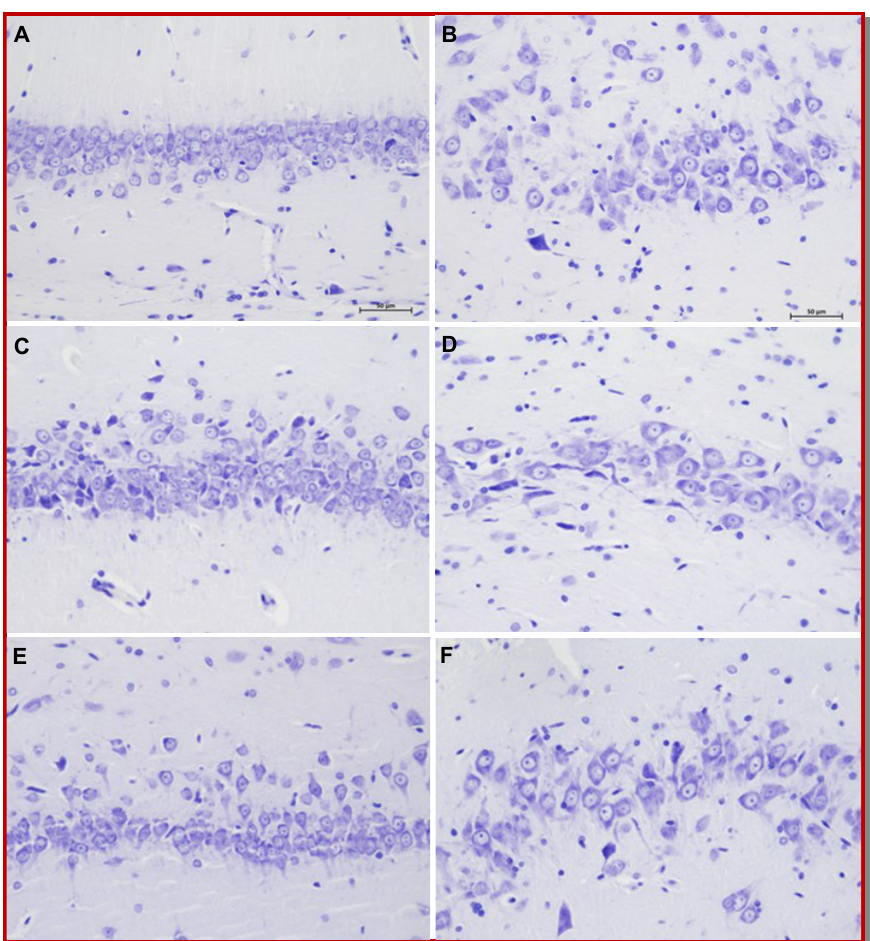
Figure 1: Microscopic view of cresyl violet stained hippocampus. Normal control group male rats CA1 and CA3. Normal pyrami- dal neuron (A-B); propionic acid and saline group male rats have neural body degeneration and decreased neural count and dys- morphological changes in CA1 and CA3 (C-D). propionic acid and medroxyprogesterone group male rats have increased neural count and improved neural morphology changes in CA1 and CA3 (scale bars = 50 μ m)